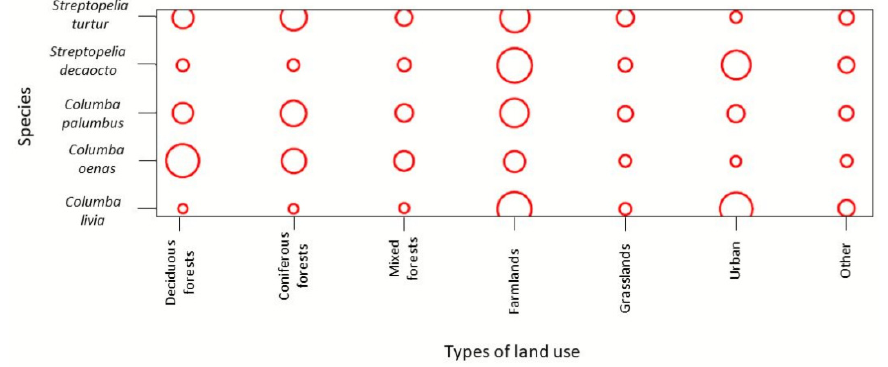
Figure 3. Habitat utilisation matrix based on land use composition around sampling points of five species from the family Columbidae in the Czech Republic. The figure provides a graphical portrayal of the observed utilisation matrix, and the increasing area of each circle is proportional to the increasing utilisation of each land use type by each species. If no circle is shown, the utilisation is zero. There are seven types of land use. Table 1. Habitat overlap among five Columbidae species (feral pigeon ( Columba livia forma domestica ), stock dove ( Columba oenas ), wood pigeon ( Columba palumbus ), Eurasian collared dove ( Streptopelia decaocto ), and European turtle dove ( Streptopelia turtur )) was estimated as a similarity index based on land use composition and two landscape metrics at each site where the species were present. Value of one suggests that the species are completely sharing resources. Value of zero indicates that the species do not share any resources. Mean—mean habitat overlaps for each Columbidae species.